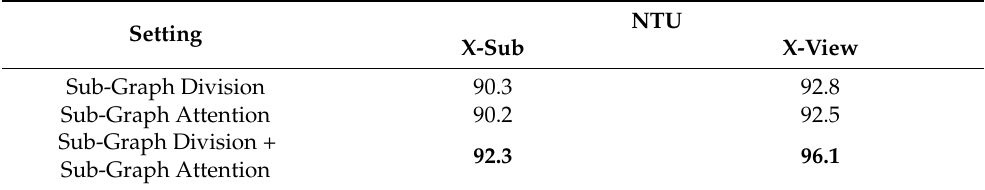
Table 4. Performance of the proposed method on the collected NTU dataset (%).